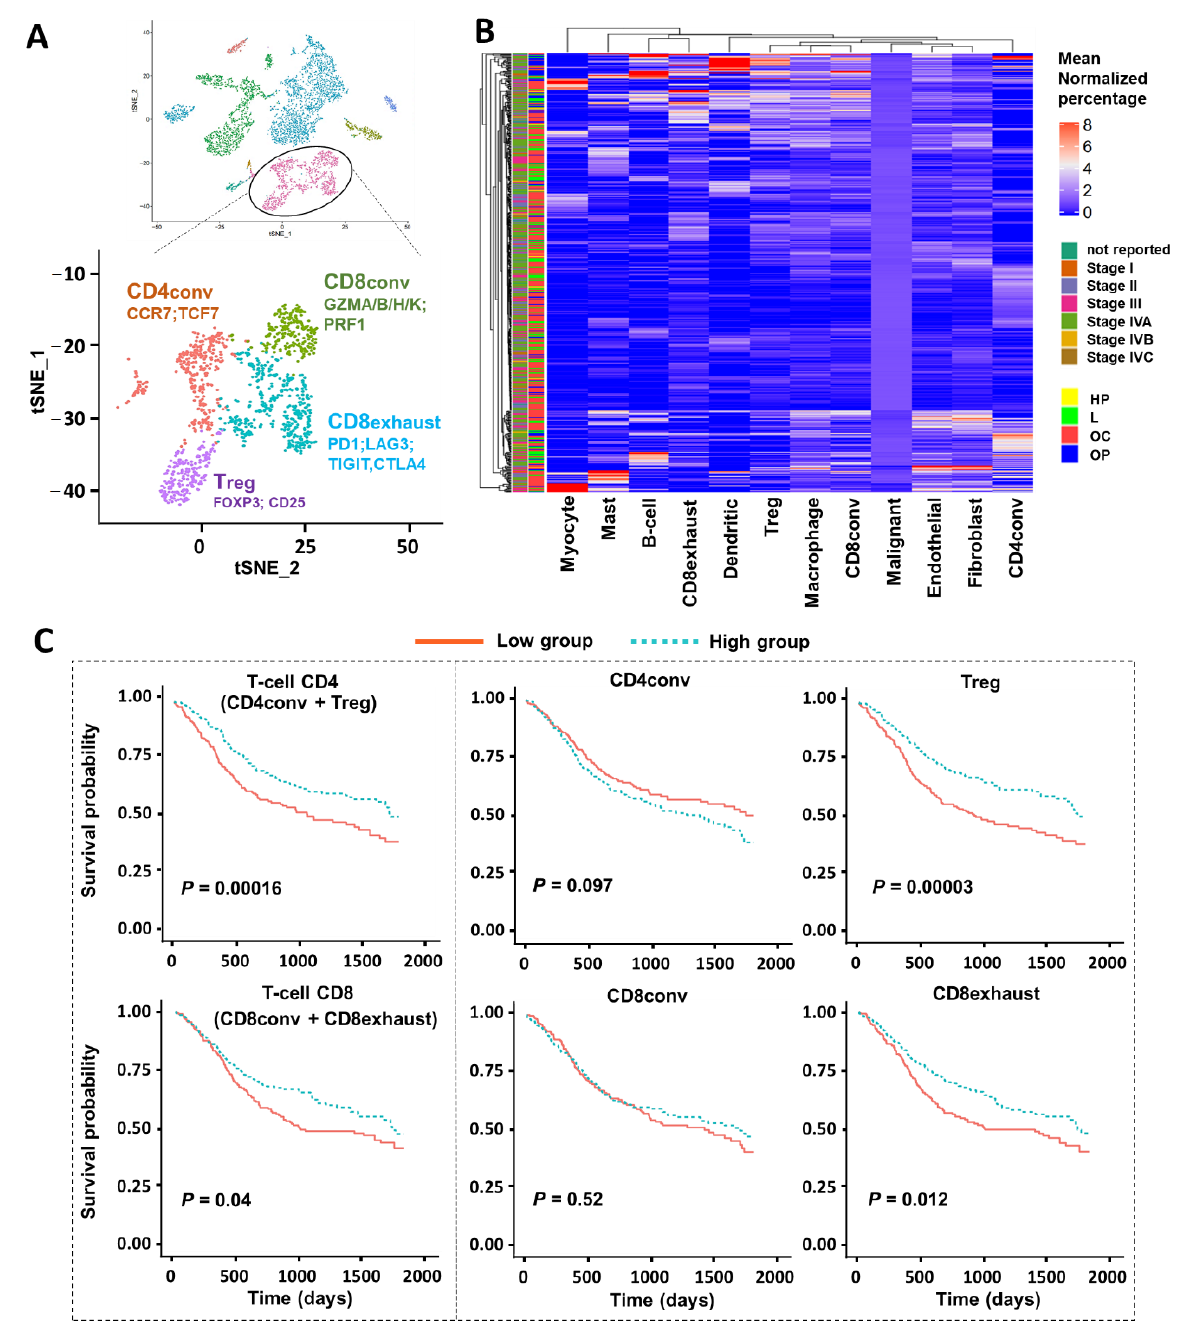
Figure 3. CIBERSORTx analysis based on T-cell subtypes/subpopulations. ( A ) t-SNE plots of T-cell population colored by four subtypes based on the corresponding marker genes: conventional CD4 T-cells (CD4conv; CCR7, TCF7), regulatory T-cells (T reg ; FOXP3, CD25), conventional CD8 T-cells (CD8conv; GZMA/B/H/K, PRF1), and CD8 exhausted T-cells (CD8exhaust; PD1, LAG3, TIGIT, CTLA4). ( B ) Heatmap of the relative cell fractions of the 12 cell types (eight major cell types and four T-cell subtypes) for each sample estimated by CIBERSORTx. The percentage is normalized by the corresponding mean within each cell type. The tissue origin and tumor stage are annotated as side bars. (HP = Hypopharynx; L = Larynx; OC = Oral Cavity; OP = Oropharynx). ( C ) Association between cell proportions and overall survival in patients with HNSCC profiled by TCGA. Estimated cell proportions were stratified by a half–half split, and the separation between survival curves was evaluated using a log-rank test. The T-cell CD4 has two subtypes: conventional CD4 cells and regulatory T-cells (T regs ). The T-cell CD8 population includes conventional CD8 T-cells and exhausted CD8 T-cells.